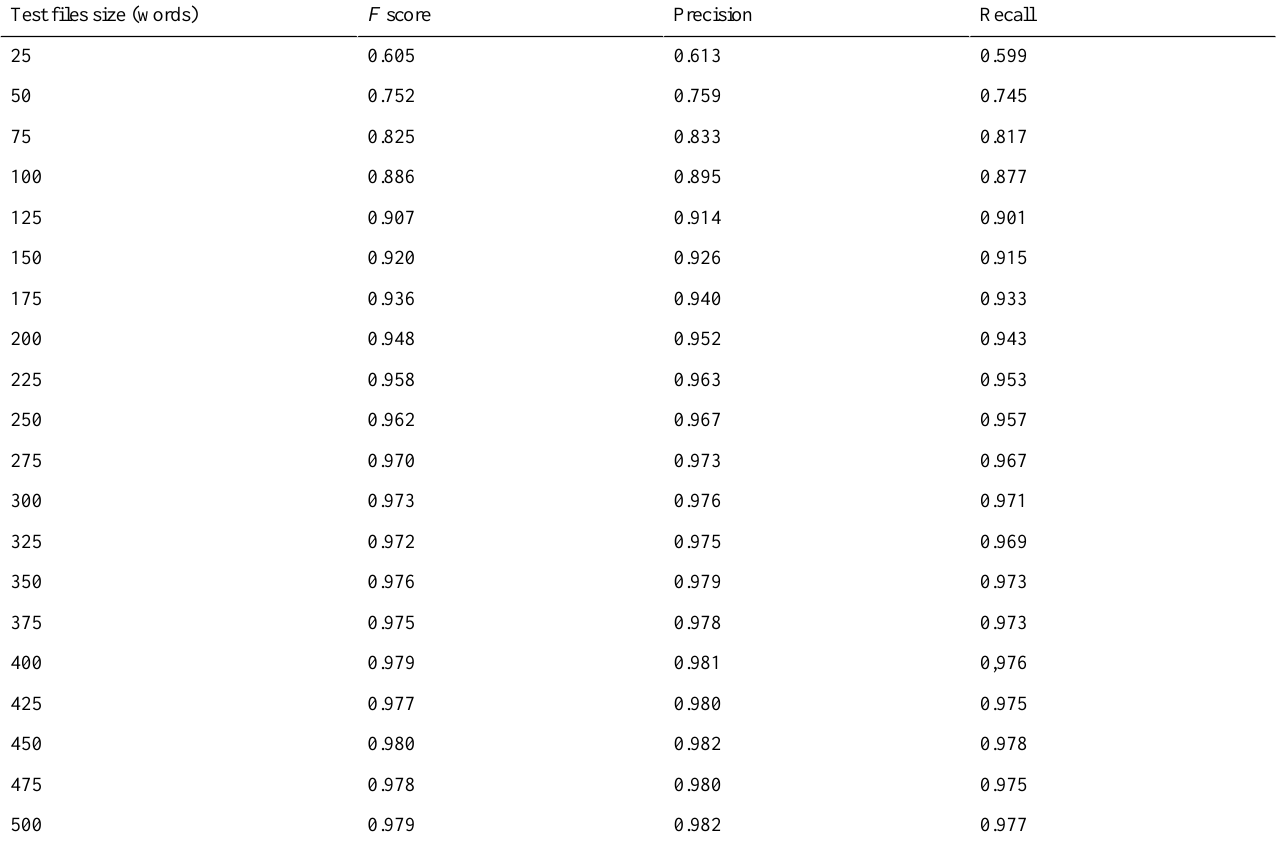
Table 8. Dependency of the results of test files size for author detection